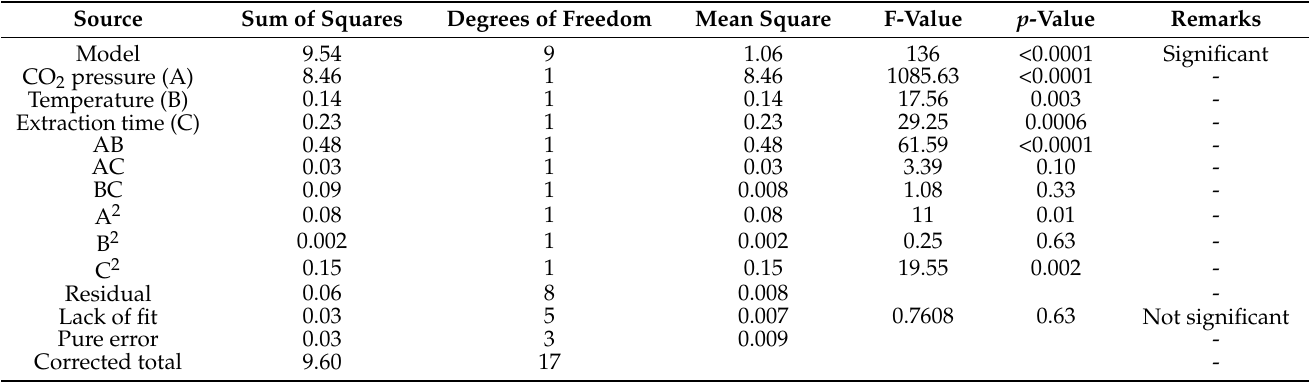
Table 4. Analysis of variance (ANOVA) of the statistical model for SCCO 2 extraction of cannabis